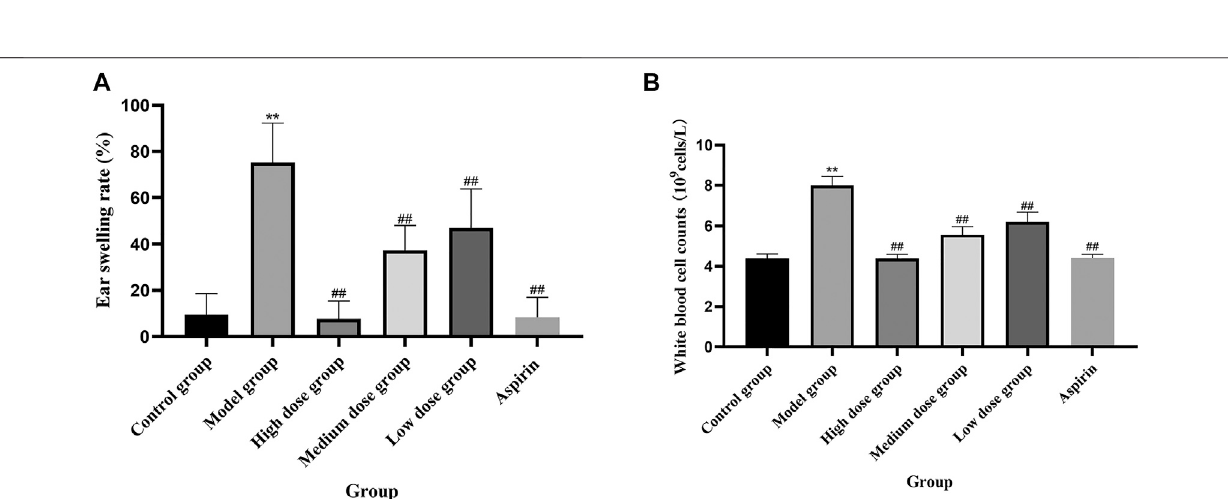
Frontiers in Pharmacology |